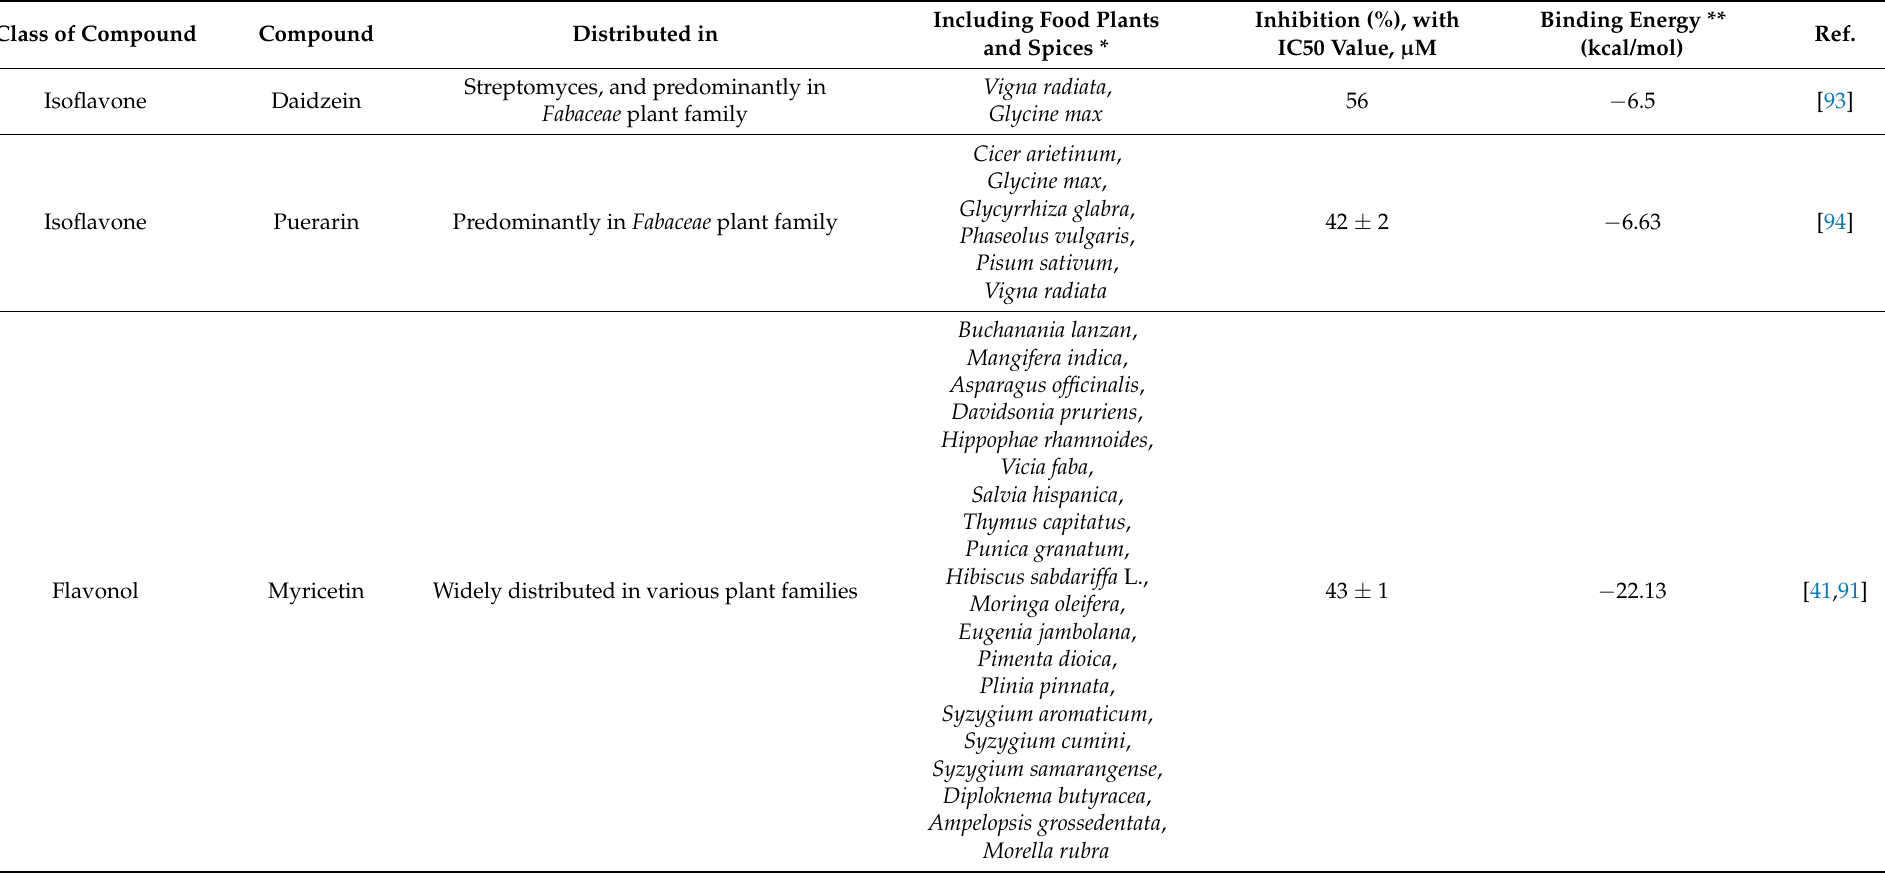
Table 1. Phytochemicals reported to have potential inhibitory properties against SARS-CoV-2